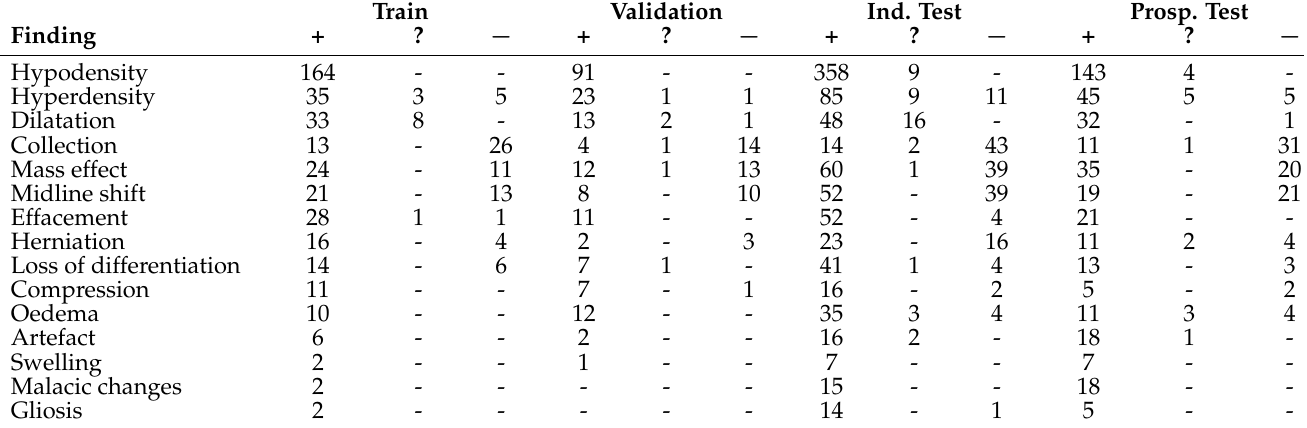
Table A2. Counts for our radiographic findings in each of our data subsets: training, validation, independent test and prospective test. “+” represents a positive mention, “?” represents an uncertain mention and “ − ” represents a negative mention. In the table body, a “-” represents 0 occurrences.